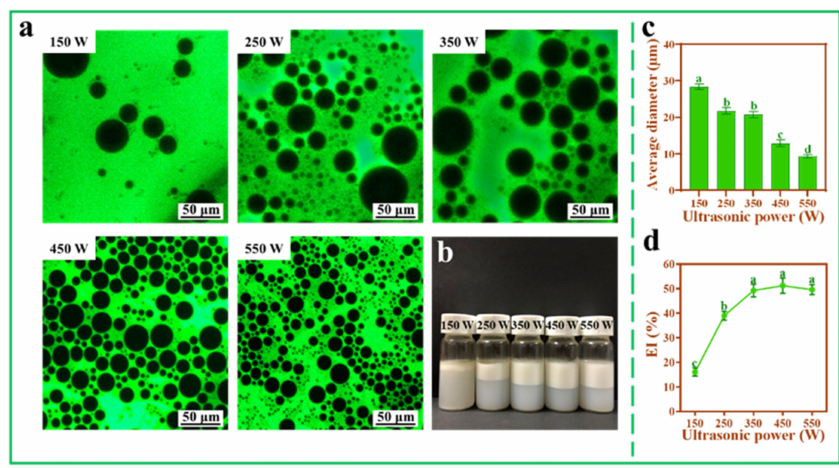
Figure 4. Inverted fluorescence microscopy images ( a ), photograph ( b ), average diameter ( c ), and EI% ( d ) of Pickering emulsions at different ultrasonic power (150, 250, 350, 450, and 550 W, pH = 7, ω (NaCl) = 0, ω (TOCNFs) = 0.9 wt%). Different letters of a, b, c and d show significant differences.